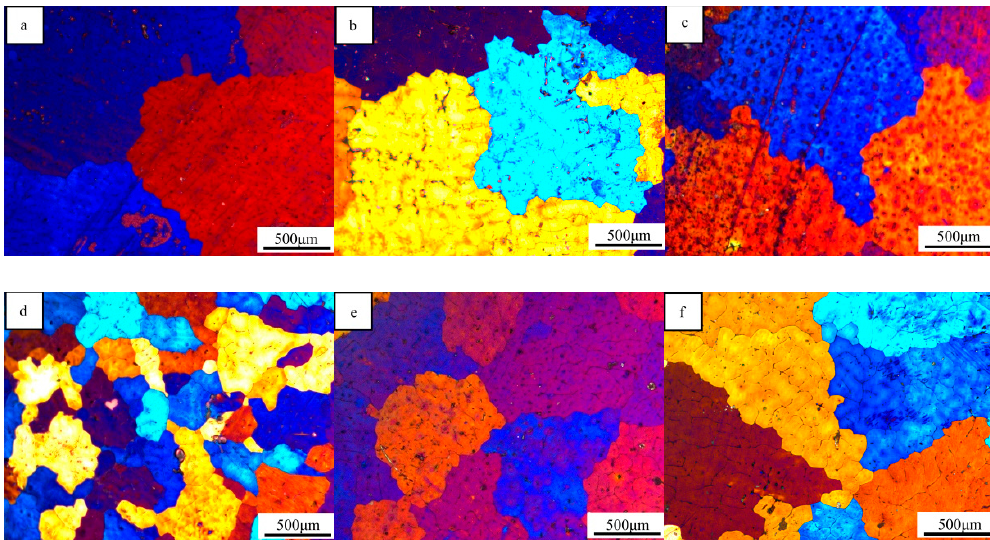
Figure 8. Macrographs of the industrial aluminum refined by different refiners. ( a ) Al-TiO 2 -C-0.2La 2 O 3 refiner; ( b ) Al-5Ti-B refiner.